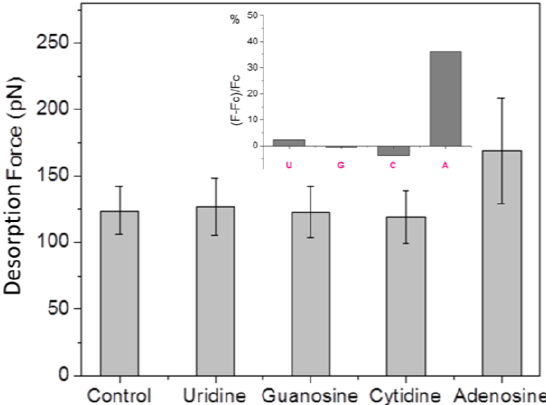
Figure 6. Mean desorption force obtained in SMFS measurements performed in pure binding buffer (control), and in the presence of uridine (U), guanosine (G), cytidine (C), or adenosine (A). The inset shows the relative force increase after addition of each analyte to the binding